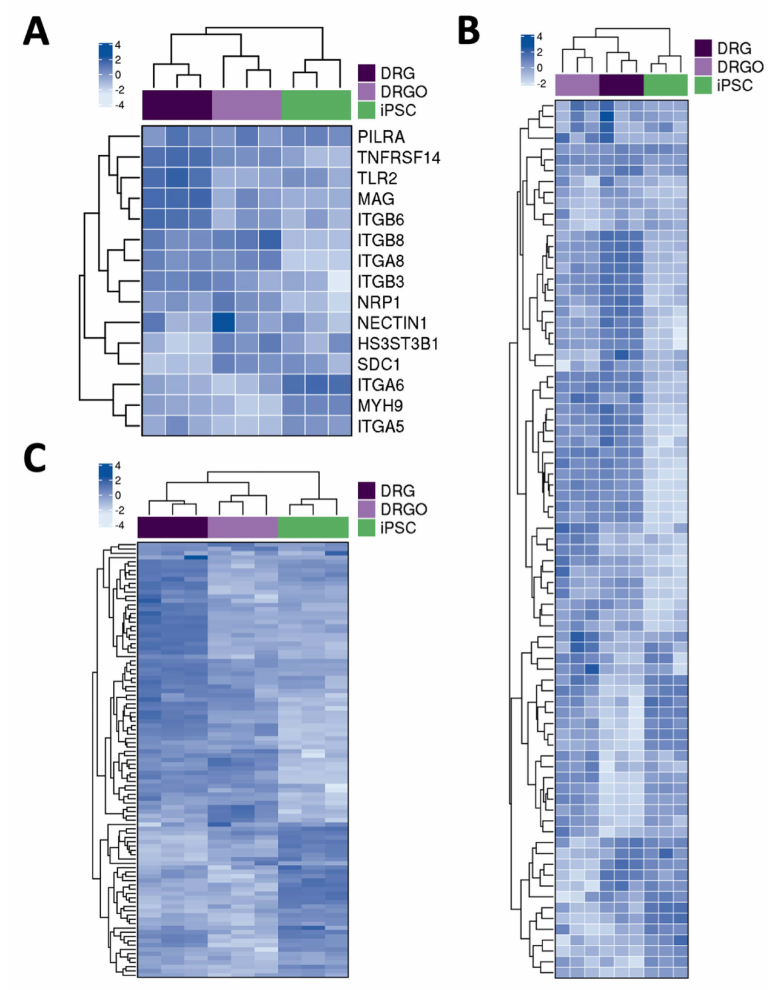
Figure 2. Global gene expression profile of HSV receptors in DRGO. ( A ) Supervised gene expression heatmaps showing the HSV receptor genes differentially expressed either in DRG vs. iPSC or in DIV 40 DRGO vs. iPSC; the correlation between samples is also shown as an unsupervised hierarchical clustered dendrogram on the side. ( B , C ) Gene expression heatmaps showing the differentially expressed genes belonging to aggregated GO categories associated with heparan sulfate biosynthetic pathways ( B ) and integrin-mediated signaling pathway ( C ); the correlation between samples is also shown as an unsupervised hierarchical clustered dendrogram on the